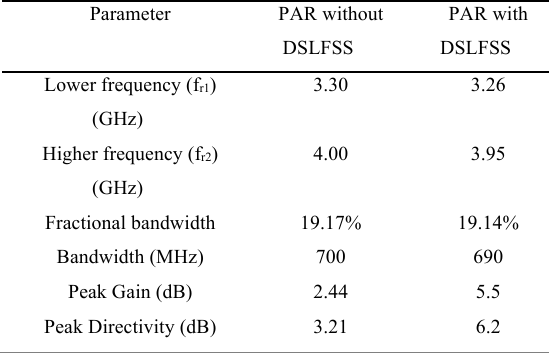
TABLE V. Performance comparison of PAR with and without DSLFSS.